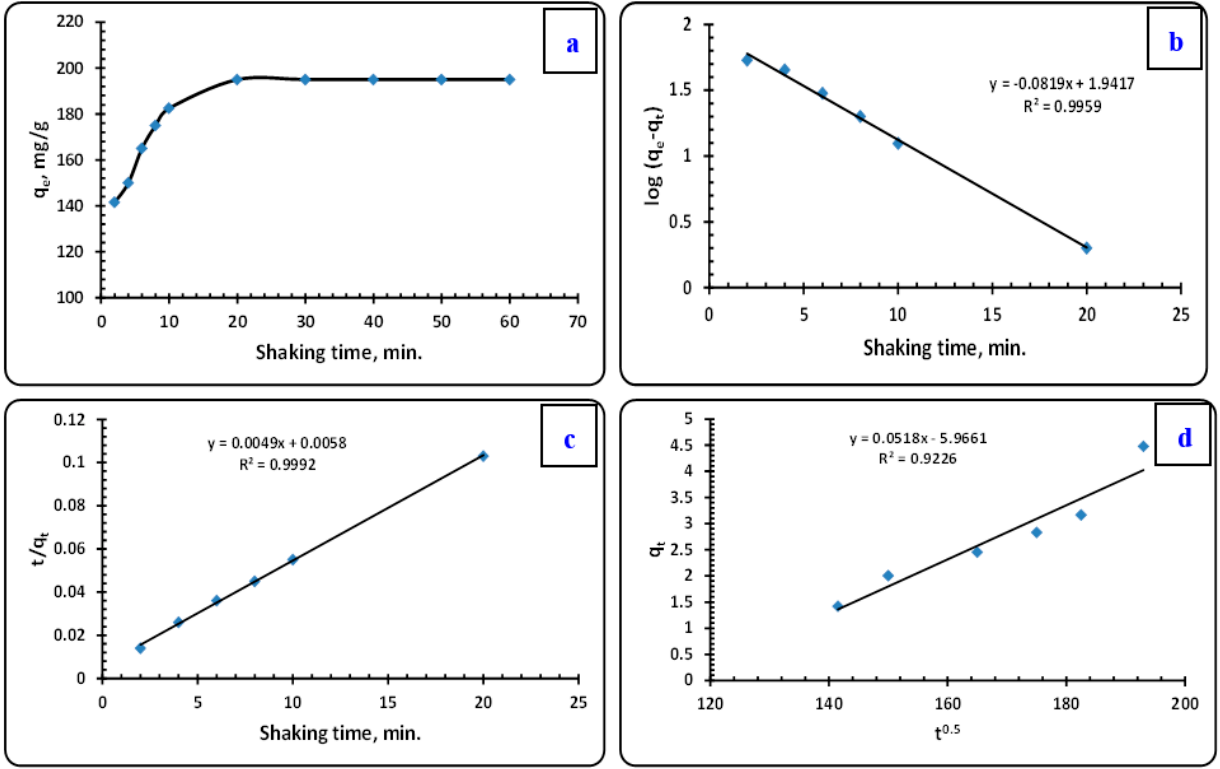
Figure 8. ( a ) Effect of shaking time on zirconium ions uptake by PPVP. ( b ) Pseudo-first-order modeling. ( c ) Pseudo-second-order modeling. ( d ) Intra-particle diffusion modeling. (Conditions: V: 50 mL, Zr concentration: 500 mg/L, m: 0.1 g, T: 25 º C, pH: 0.)